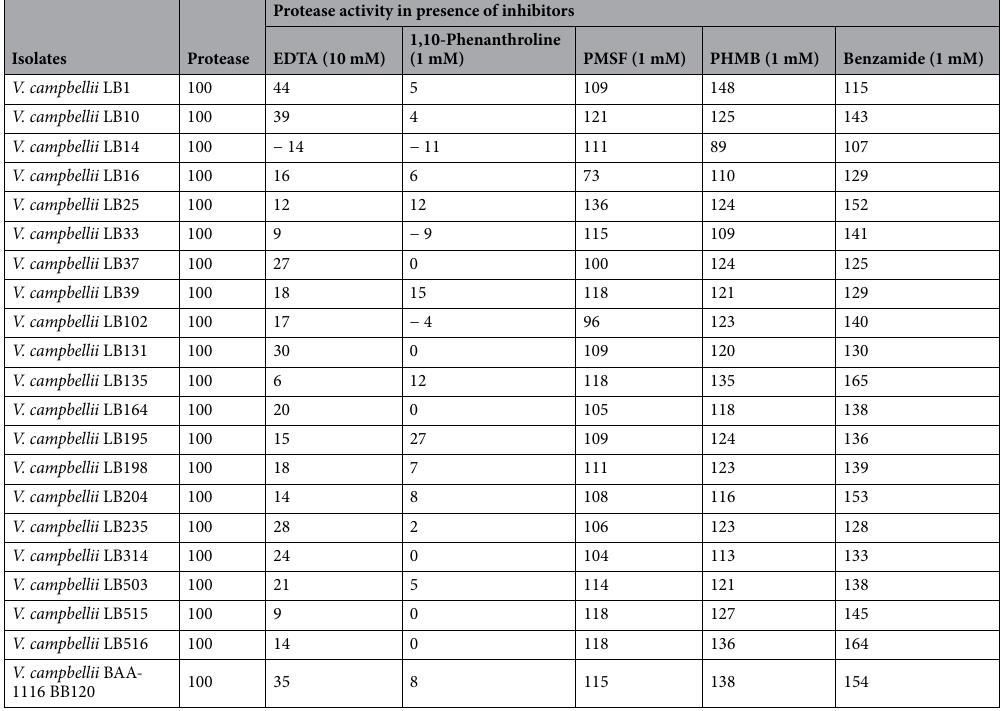
Table 2. Effect of inhibitors on protease activity in Vibrio campbellii. The concentration of protease inhibitors applied are presented in parenthesis. EDTA ethylenediaminetetraacetic acid; PMSF phenylmethylsulfonyl fluoride; PHMB p-hydroxymercuribenzoate.